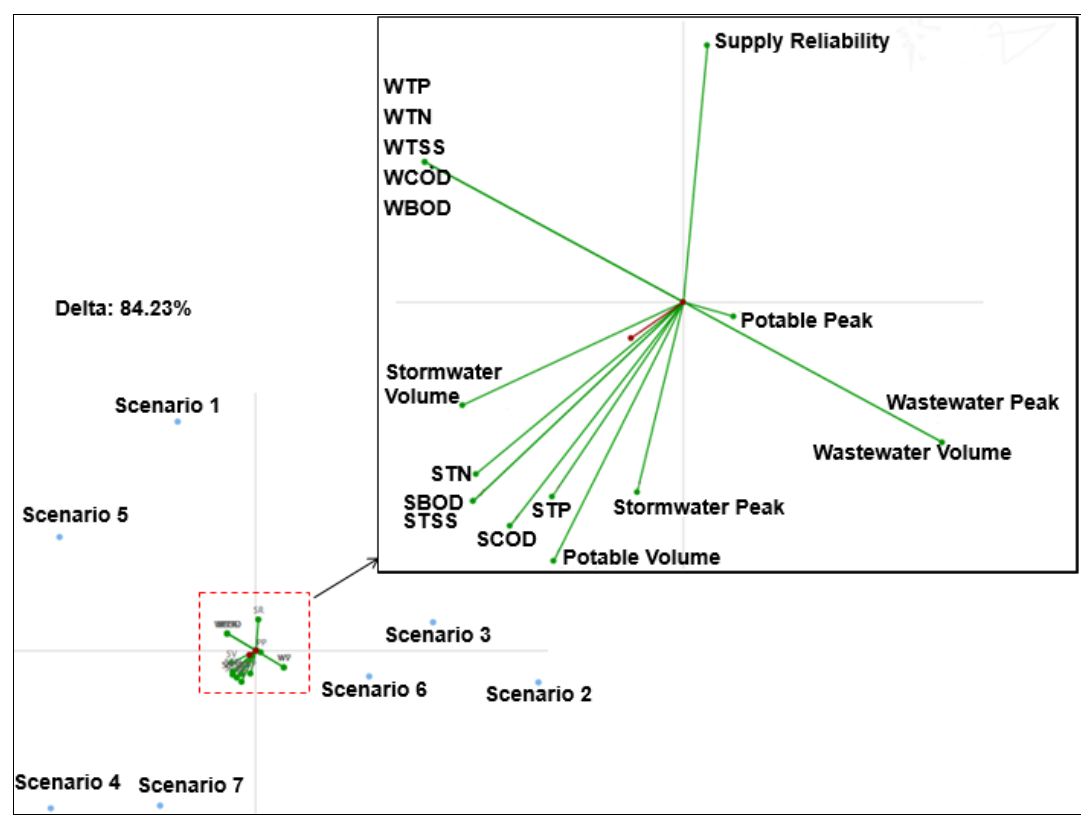
Figure 4. Spider web chart for different hybrid water supply scenarios.